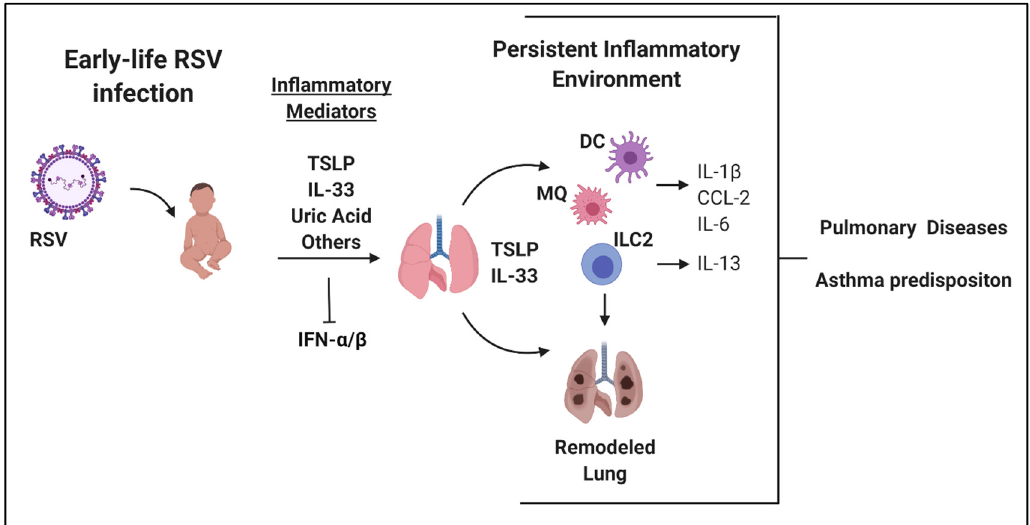
Figure 1. Overview of early-life respiratory syncytial virus (RSV) infection and long-term local alterations within the lung. Figure created using Biorender.com .